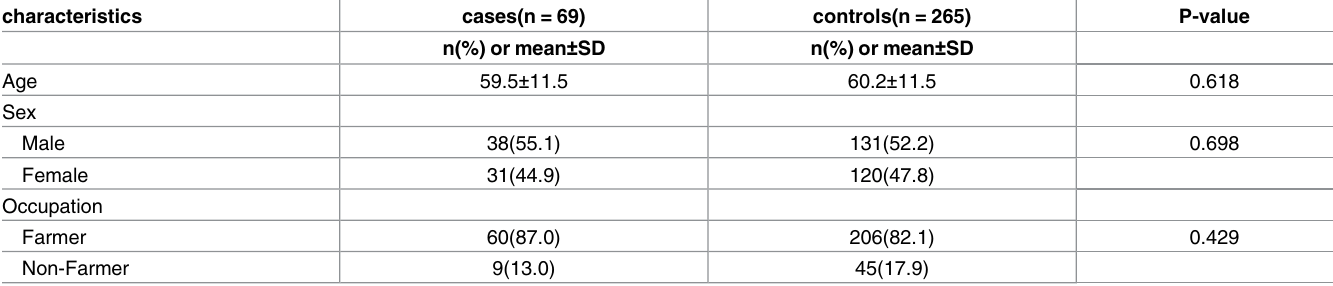
Table 1. Demographic characteristics of the cases and